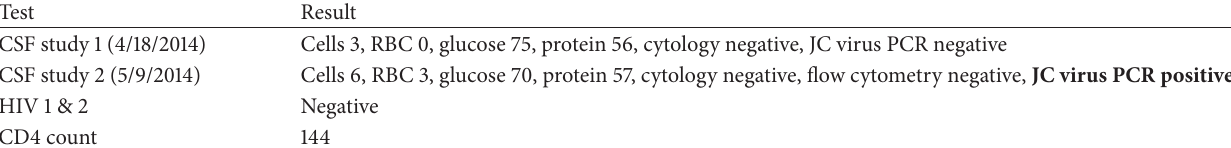
Table 1: Laboratory and diagnostic